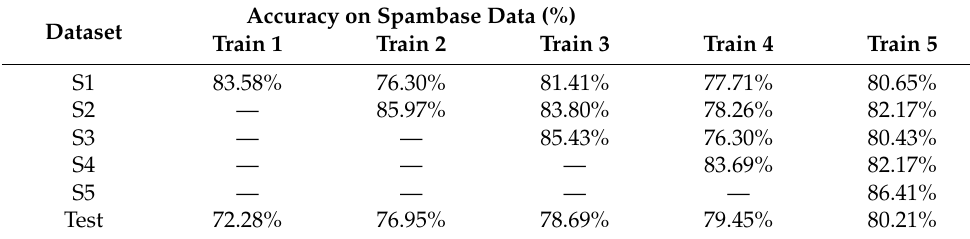
Table 7. Result of ISVM_DD on spambase